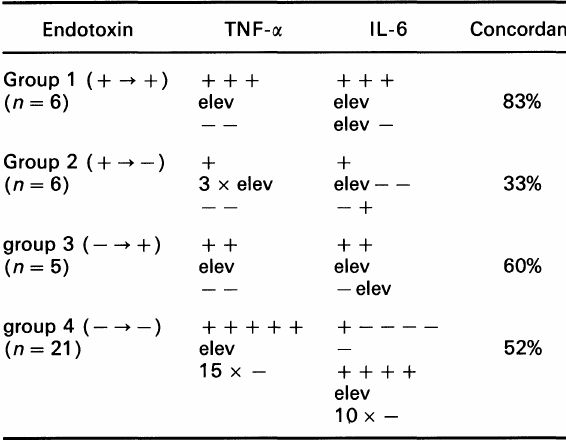
Table 1. Intraoperative courses of TNF- and IL-6 in individual liver graft recipients, grouped according to their endotoxin plasma concentrations at the beginning and end of operation